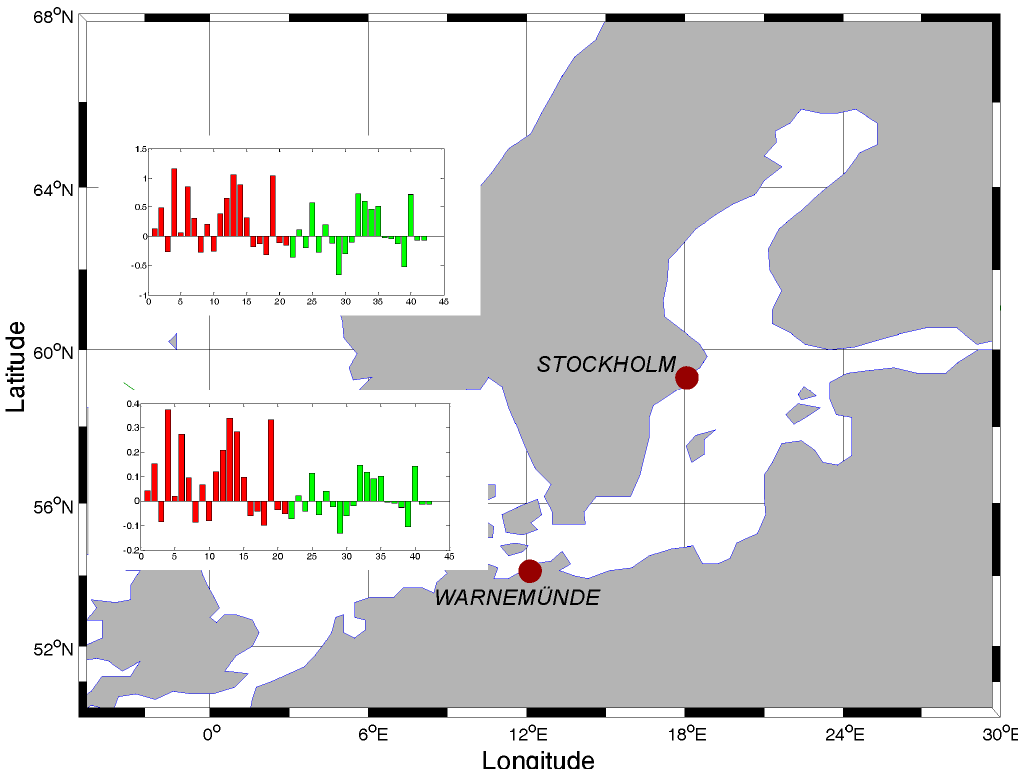
Figure 4. The Baltic Sea region map including the locations of Stockholm and Warnemünde tide gauges. The bar graphs show the atmospheric index driven trend estimations of the sea-level (mm/year). The panel at the top (bottom) shows the BANOS-red and NAO-green driven sea-level trends in Stockholm (Warnemünde). The estimations are ordered based on the performance of the CMIP5 models. For instance, the first three estimations are deduced from realizations of the model HadGEM2-ES for each index.